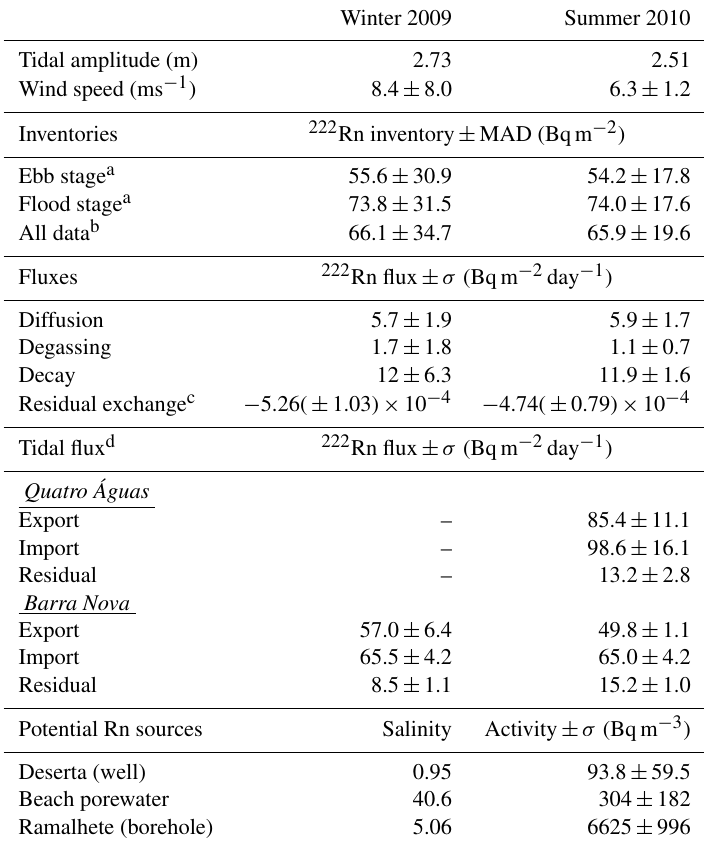
Table 1. Excess 222 Rn inventories and relevant fluxes supporting the radon mass balance for the Ria Formosa in winter 2009 and summer 2010 (see Sects. 4.1 and